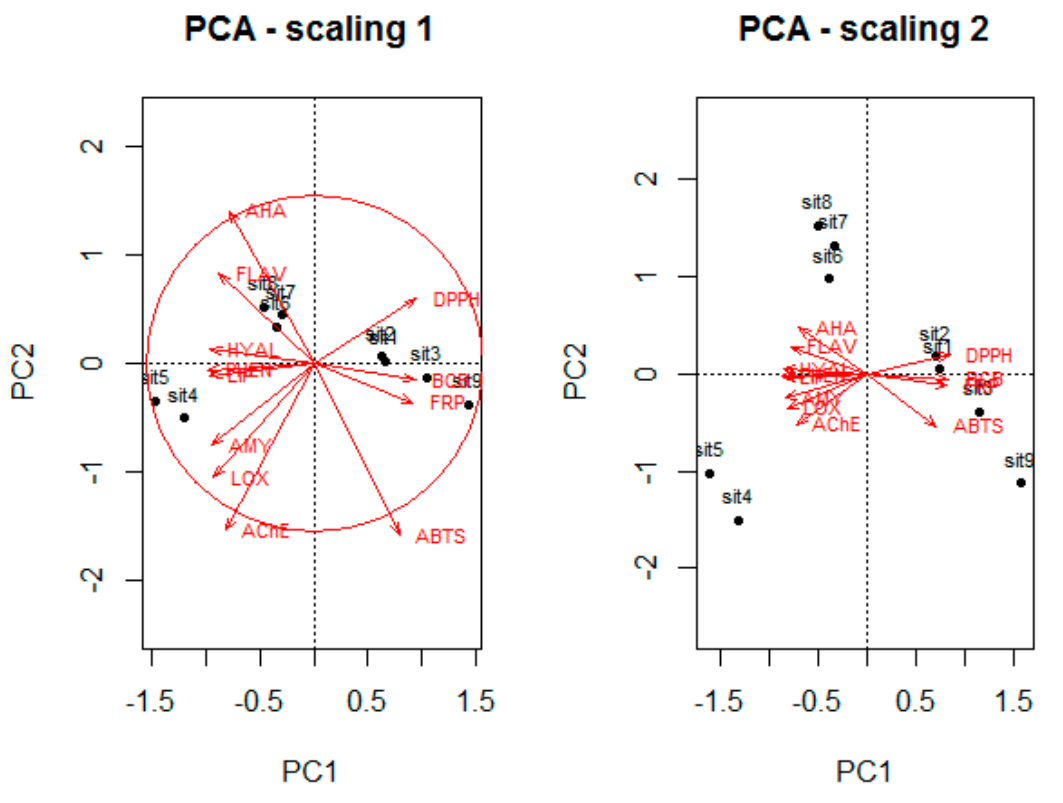
Figure 3. PCA biplots of total phenolic and flavonoid, enzyme inhibitory and antioxidant activities. The bottom and left-hand scale regard the bee pollen extract, while the top and right-hand scale are for the variables. PC1 and PC2: 80% and 11%, respectively, of proportion explained.